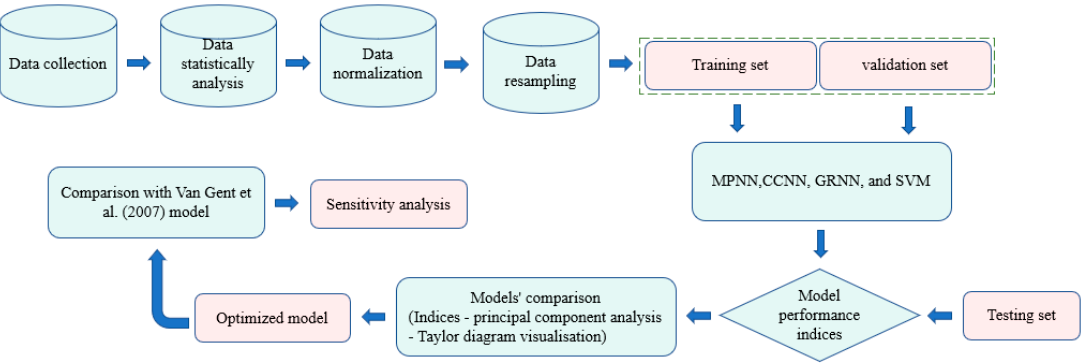
Figure 3. Flowchart of ANN and SVM models used for wave-overtopping prediction.